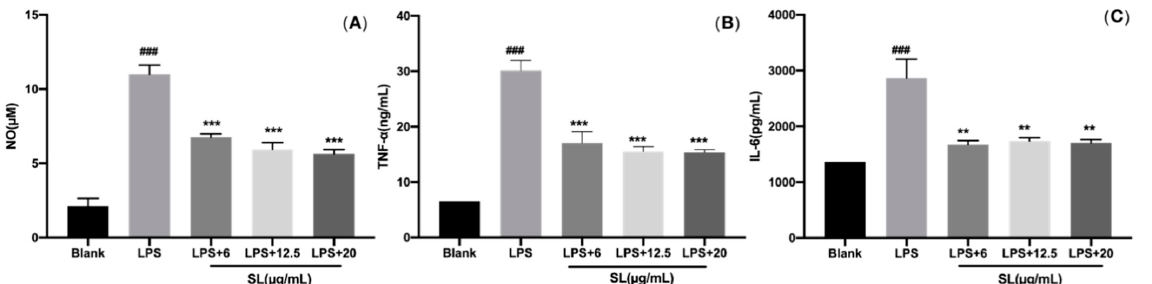
Figure 3. Effect of SLs on the LPS-induced inflammation in RAW264.7 cells. Cells were incubated